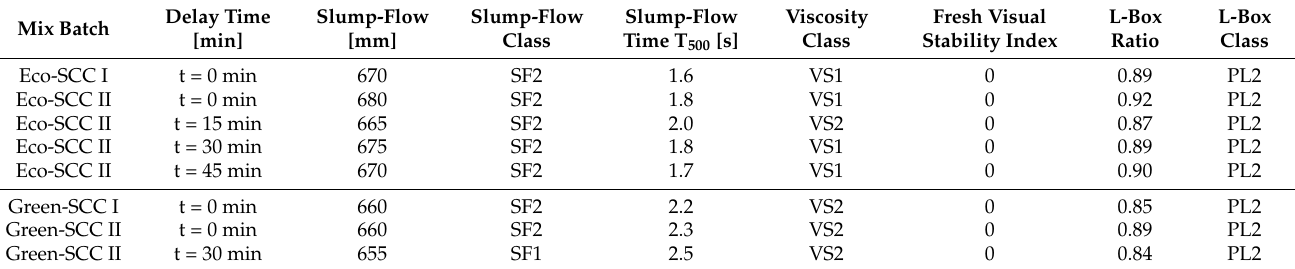
Table 2. Fresh properties of eco-efficient SCC mix batches.